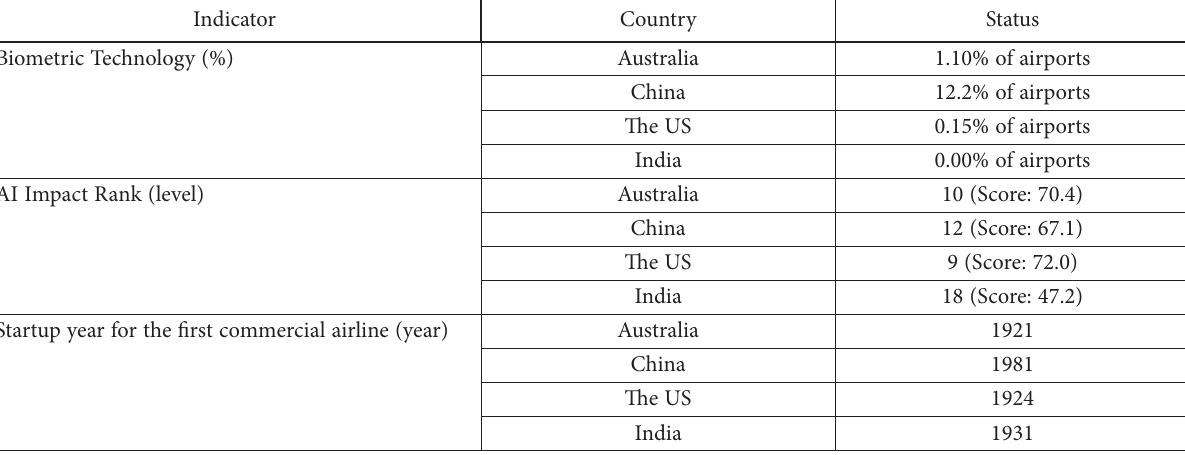
Table 2. The biometric technology, AI impact and startups in aviation in Australia, China, the US and India about in 2018 Indicator